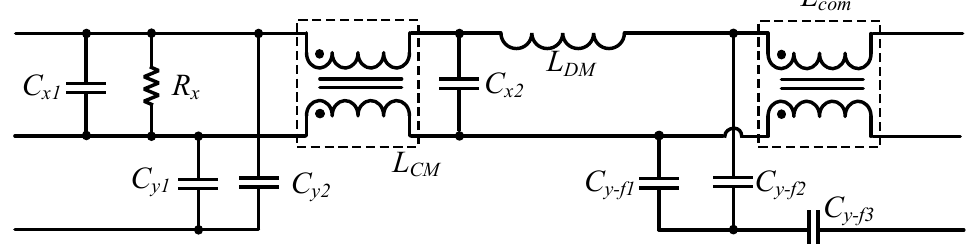
Figure 9. Two-stage electromagnetic interference (EMI) filter.